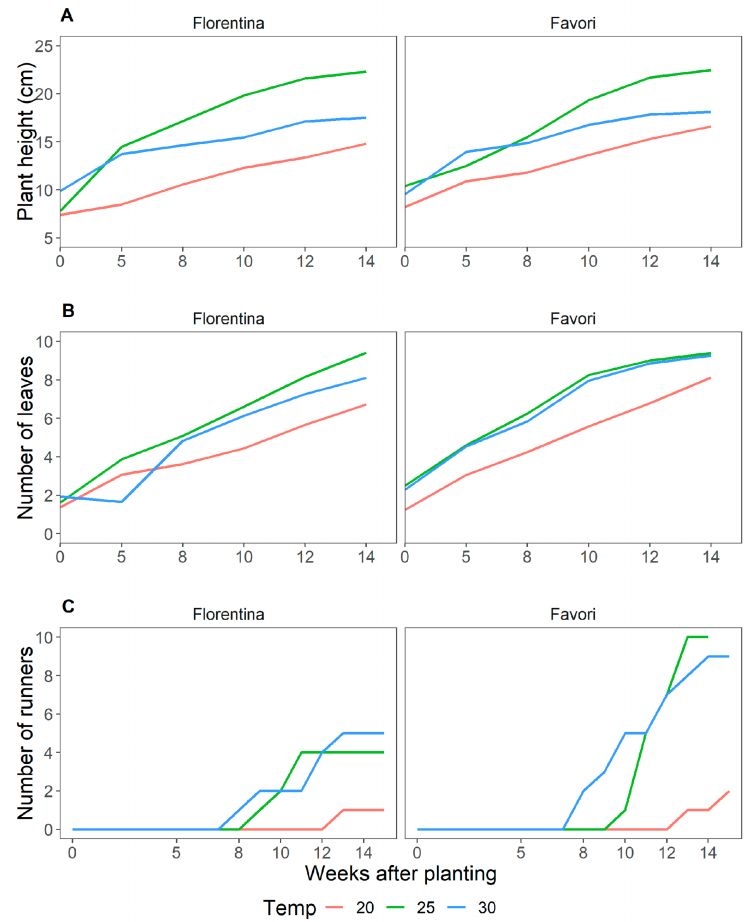
Figure 1. Average plant height in cm ( A ); average number of leaves ( B ), starting at W0; and number of runners ( C ), starting at W8 for strawberry plants of cvs. ‘Florentina’ (N = 30–32) and ‘Favori’ (N = 20–34) during 14 weeks at ambient natural short day at 20 ◦ C, 25 ◦ C, and 30 ◦ C (Expt.